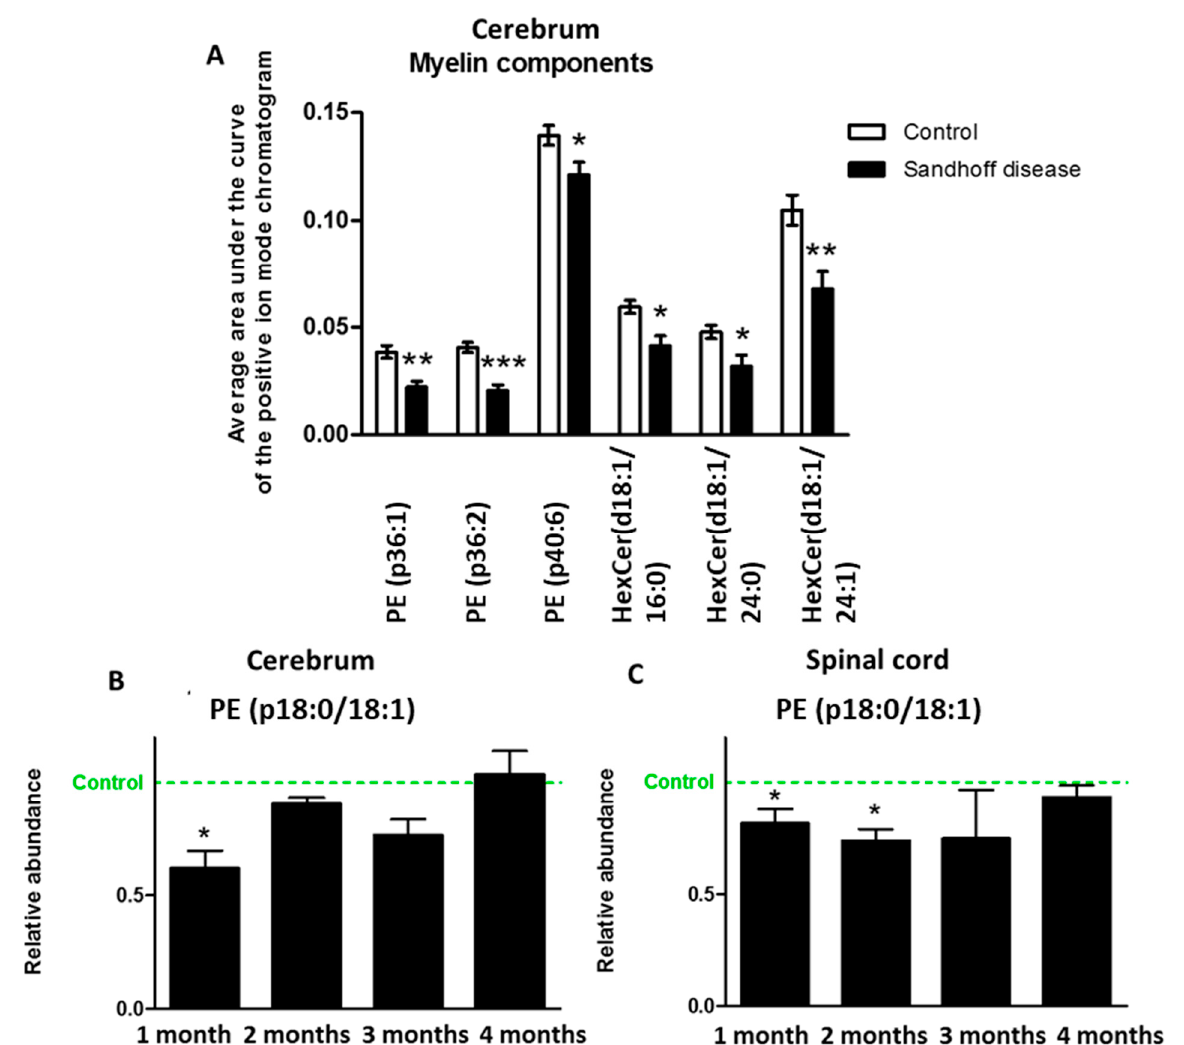
Figure 4. Measurement of myelin components using LC-MS. ( A ) concentration of major components of myelin, plasmalogen-phosphatidylethanolamine and hexose-ceramide species, in cerebrum tissue from one-month-old control and Hexb − / − mice. ( B ) concentration of plasmalogen-phosphatidylethanolamine 36:1 (PE (p18:0/18:1)) in cerebrum from Sandhoff disease (SD) mice relative to controls (abundance set to 1). ( C ) concentration of plasmalogen-phosphatidylethanolamine 36:1 (PE (p18:0/18:1)) in spinal cord from SD mice relative to controls (abundance set to 1). Results are presented as mean +/- SEM. Significance level quoted for Student’s t -test * p ≤ 0.05; ** p ≤ 0.01; *** p ≤ 0.001.